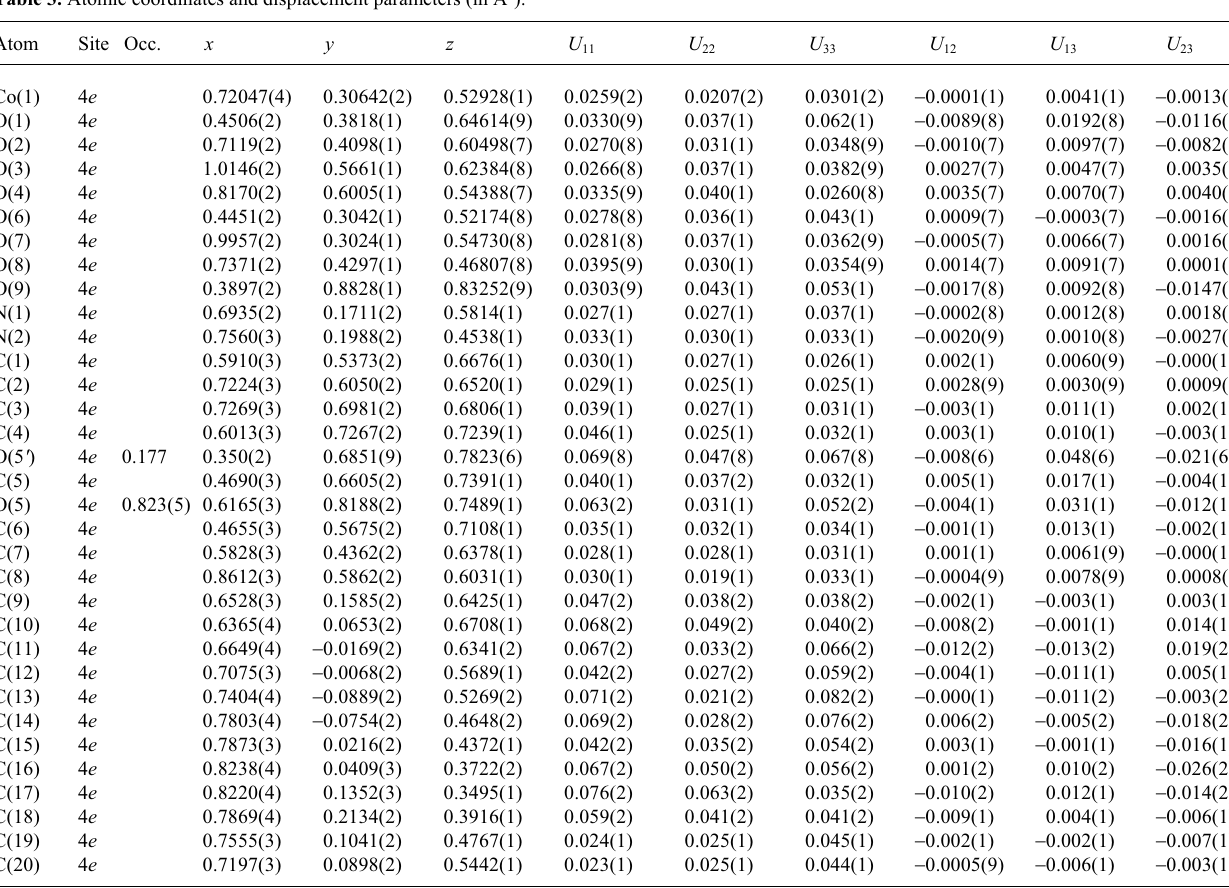
Table 3. Atomic coordinates and displacement parameters (in Å 2